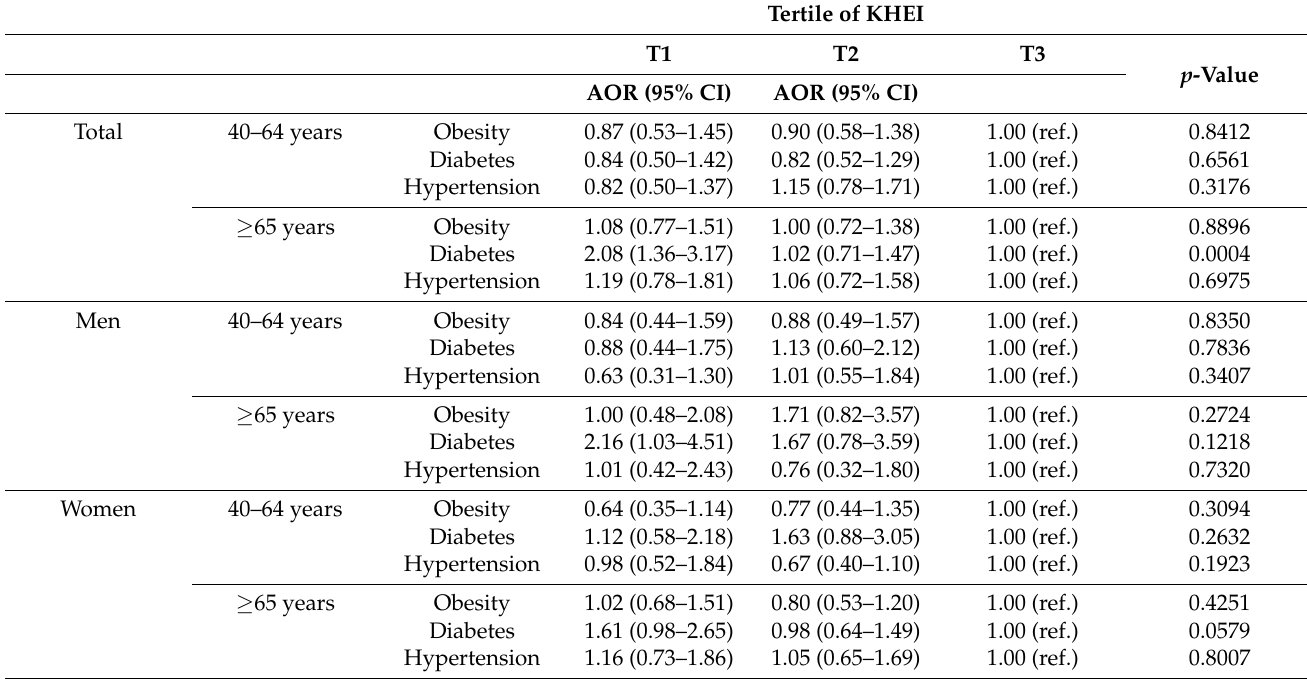
Table 4. Adjusted odds ratios with 95% confidence intervals for obesity, diabetes, and hypertension by KHEI score among single-person households in